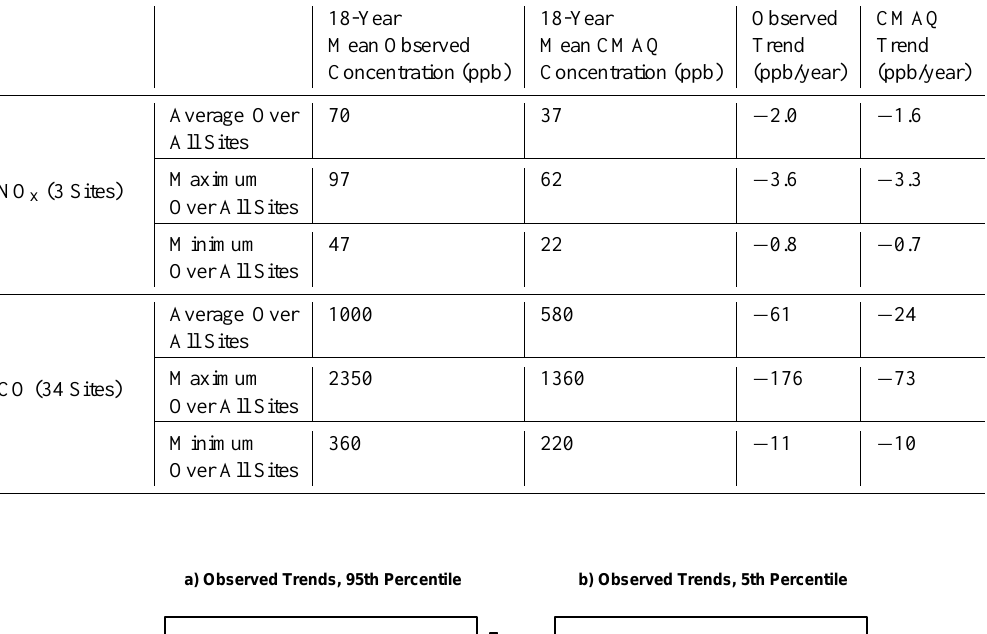
Table 4. Observed and CMAQ/STATIC NO x and CO concentrations and trends at 3 NO x and 34 CO AQS sites, 1988–2005. The analysis considered year-round 06:00a.m.–09:00a.m. average concentrations. The observed and modeled trends shown in the “maximum over all sites” and “minimum over all sites” rows reflect the trends at the sites with the maximum/minimum 18-year mean concentrations shown in the first two data columns of these rows. Note that many AQS CO monitors report concentrations only in part per million (ppm) or parts per ten million. The ppb values shown in this table are the result of temporal averaging and trend analysis.